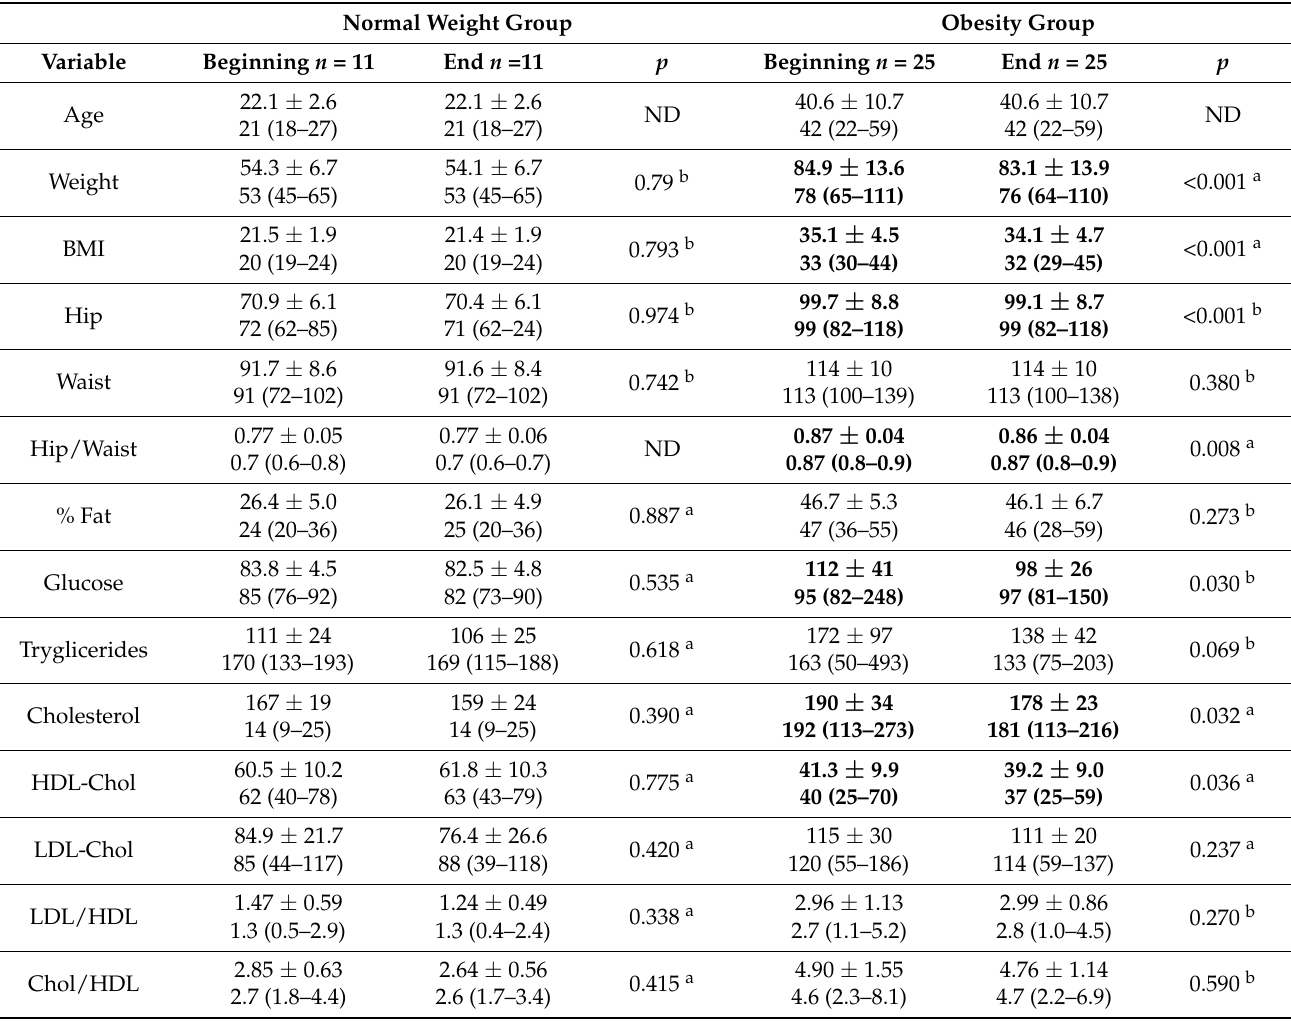
Table 1. Anthropometric and biochemical variables shown by